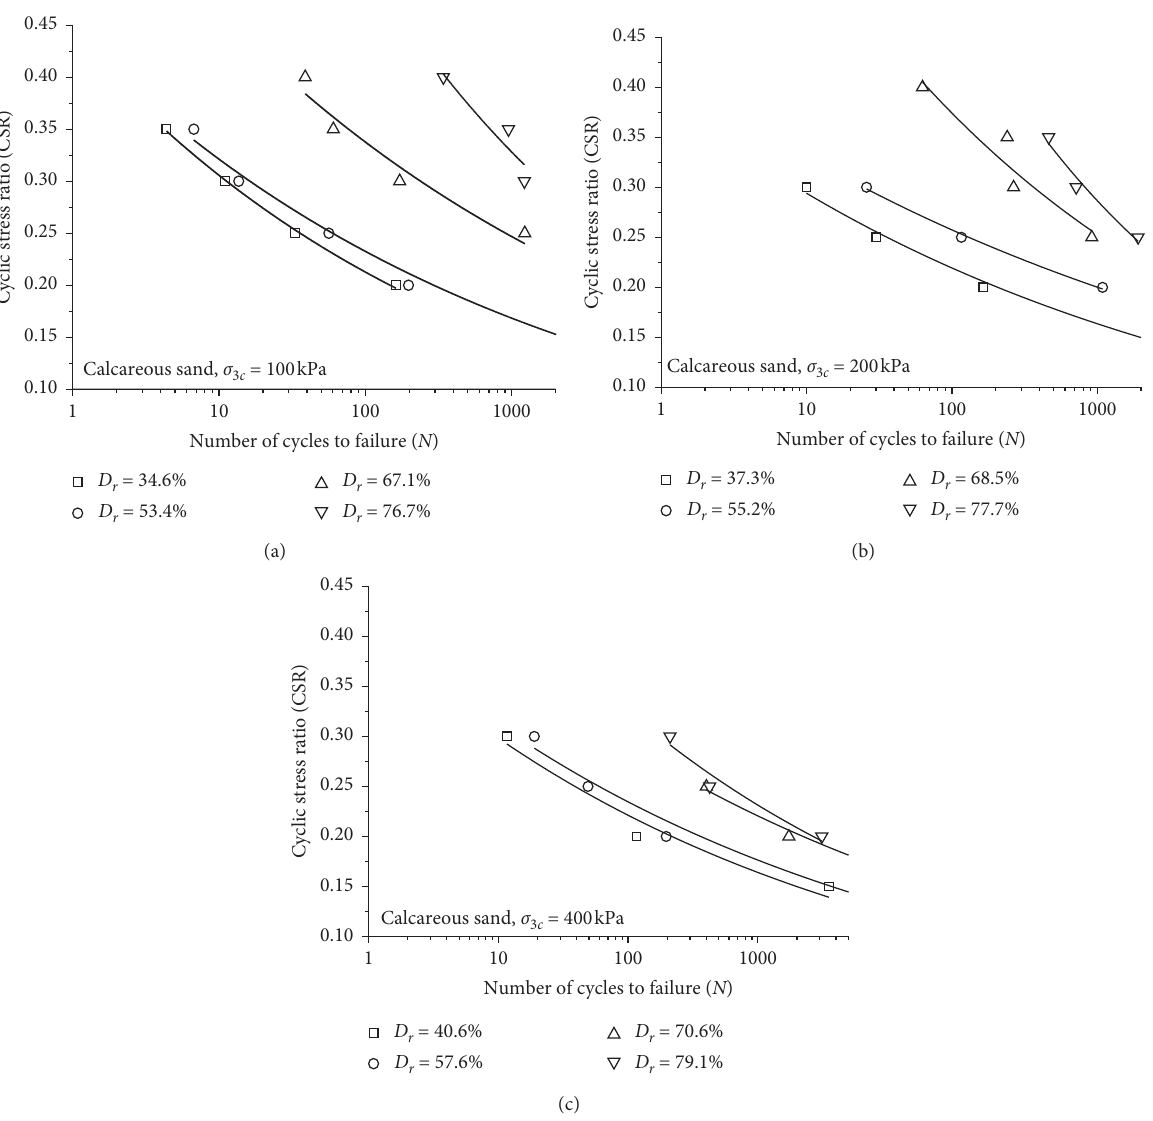
� 100kPa. (b) σ � 200kPa. (c) σ � 3 c 3 c